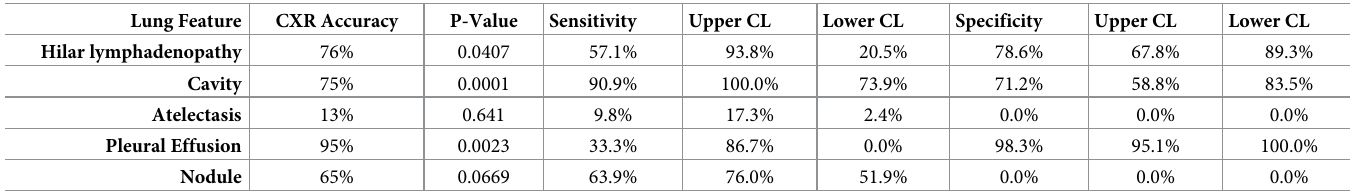
Table 6. 63 TBPP CXR Annotations for Relapse TB Patient Case versus Qure.ai Binary Prediction, Crosstabulation Summary Statistics. Lung